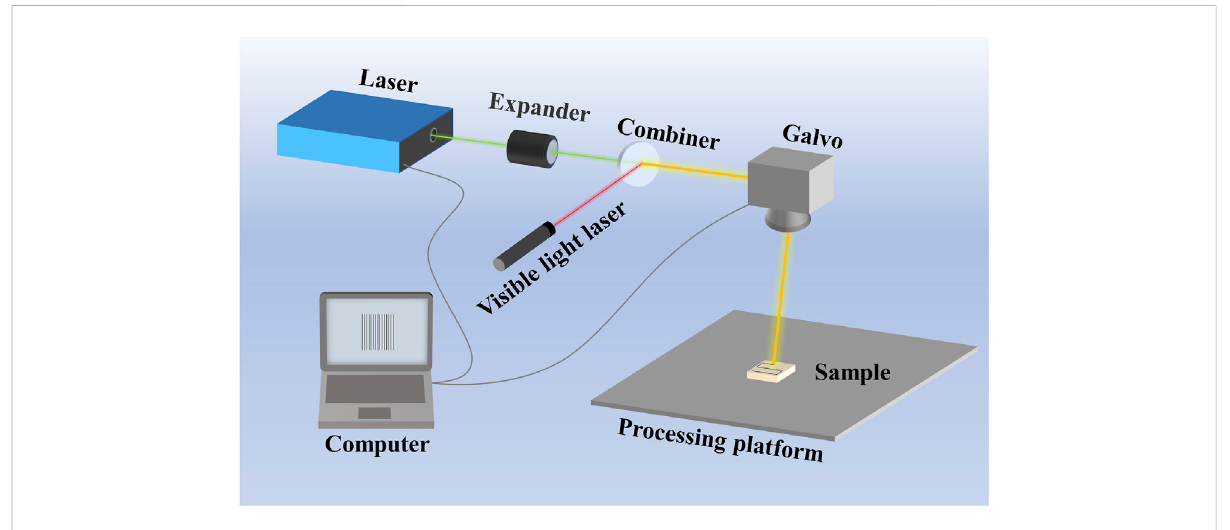
FIGURE 1 The schematic of laser surface